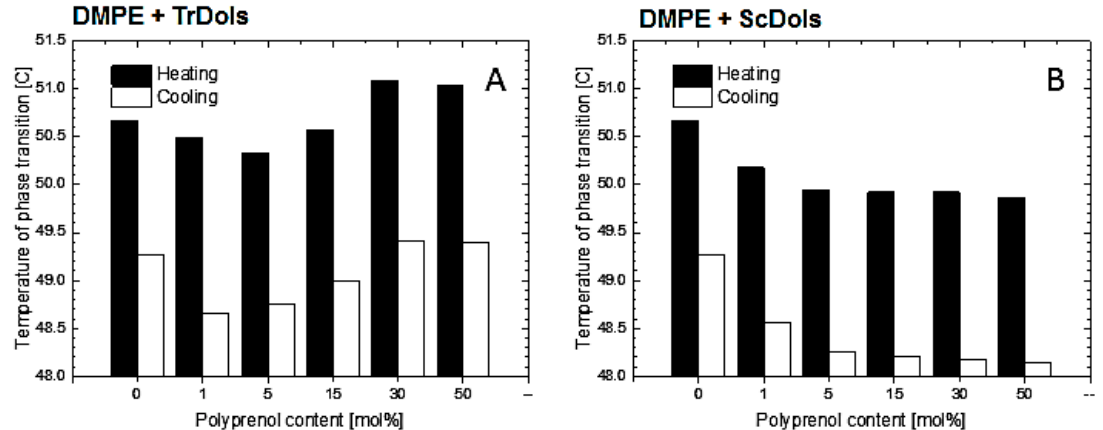
Figure 10. Influence of concentration of dolichol on phase transition temperature of DMPE membranes. Phase transition temperature of DMPE multilamellar vesicles obtained in the cooling and heating modes for TrDols ( A ) and ScDols ( B ).